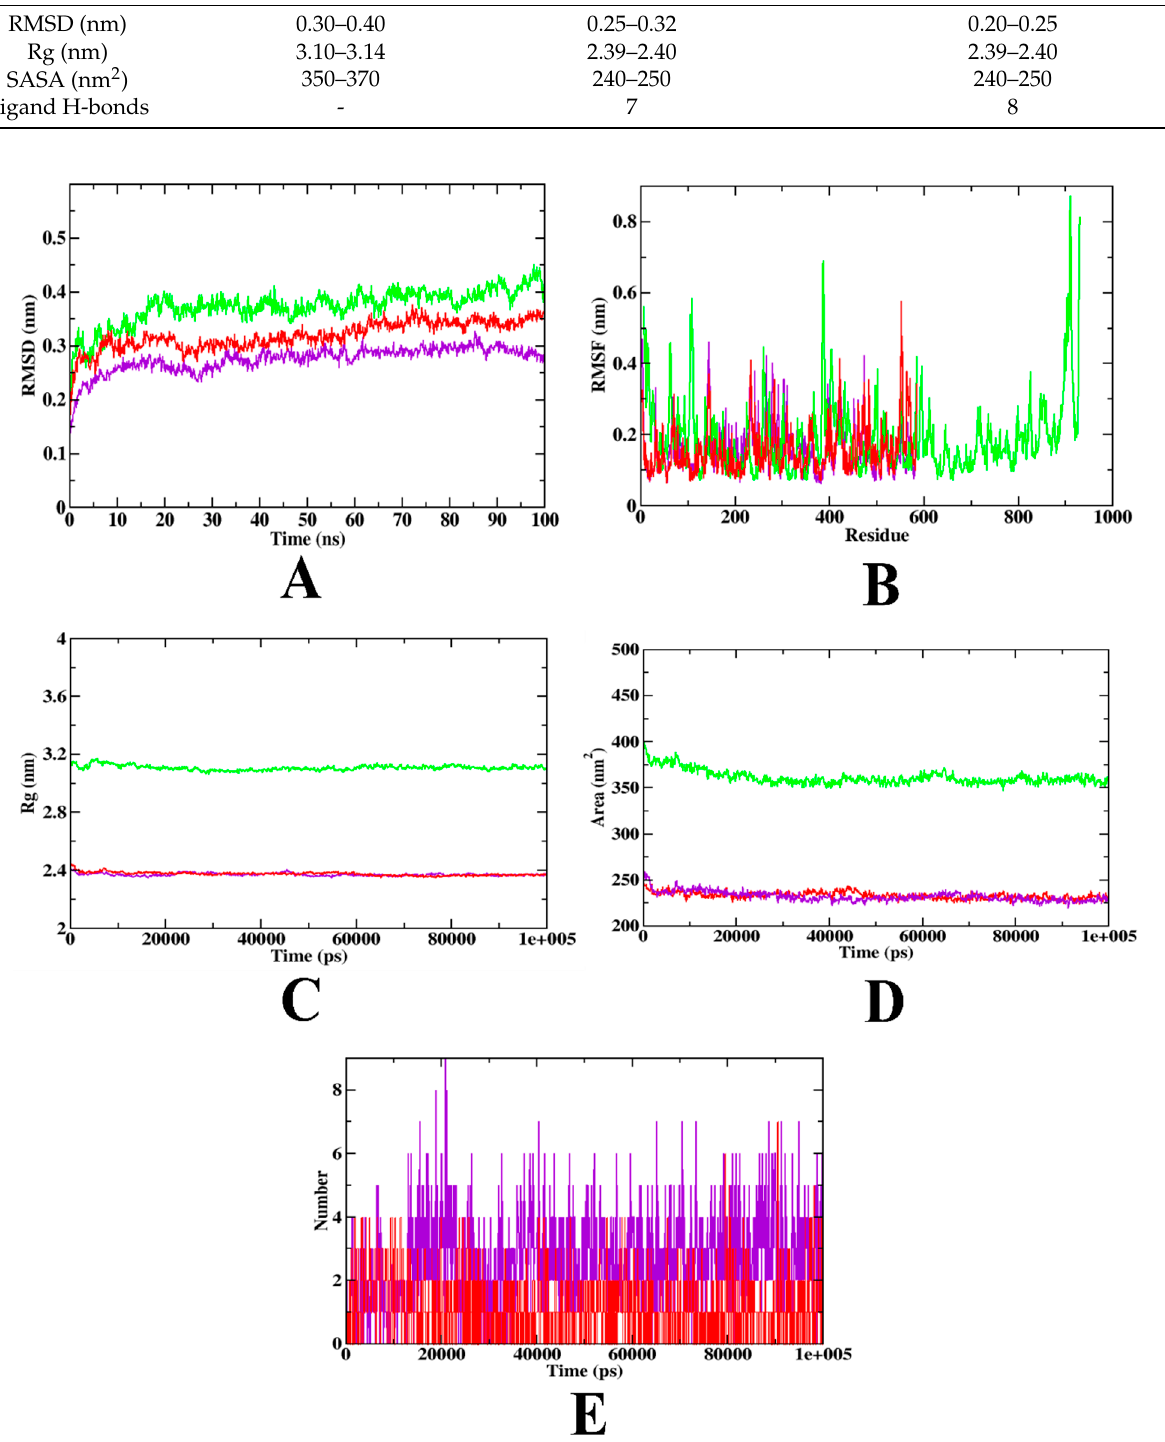
Figure 10. MD simulation trajectories plo tt ed to show the comparative stability of ligands inside the inhibitor binding site of α -glucosidase ( A ) RMSD, ( B ) RMSF, ( C ) Rg, and ( D ) SASA, and ( E ) Ligand H-Bonds. Red: protein-acarbose; purple: protein-hydroxyacetic acid complex, and green: apo-protein.